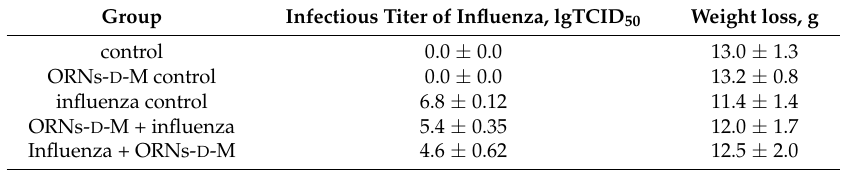
Table 1. Decrease of the influenza virus A/Fort Monmouth/1/1947-mouse adapted (H1N1) infectious titer in lungs and weight loss of infected mice after prevention and treatment with the ORNs- D